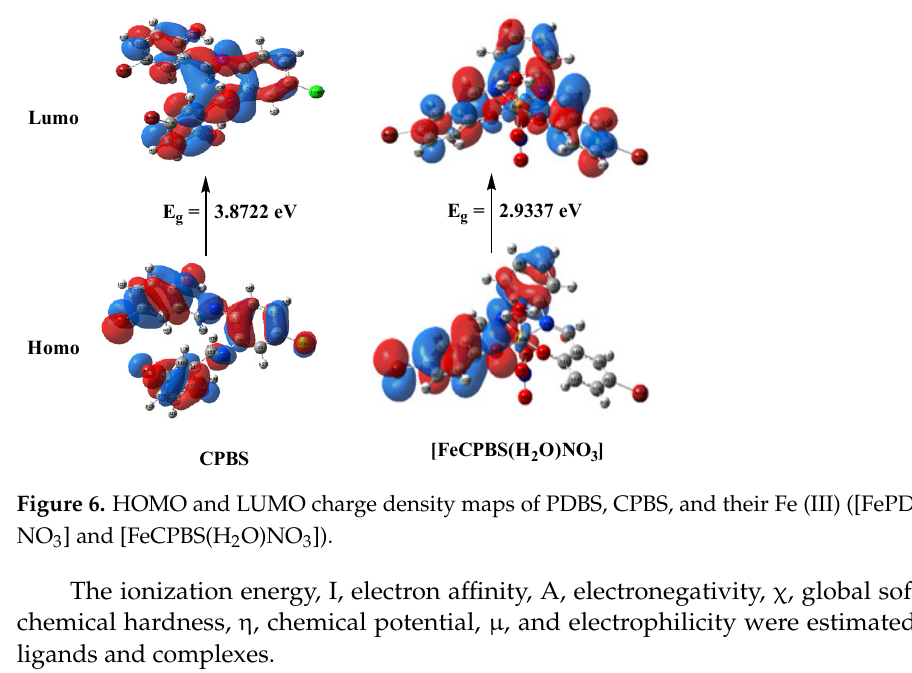
Figure 6. HOMO and LUMO charge density maps of PDBS, CPBS, and their Fe (III) ([FePDBS(H 2 O) NO 3 ] and [FeCPBS(H 2 O)NO 3 ]).